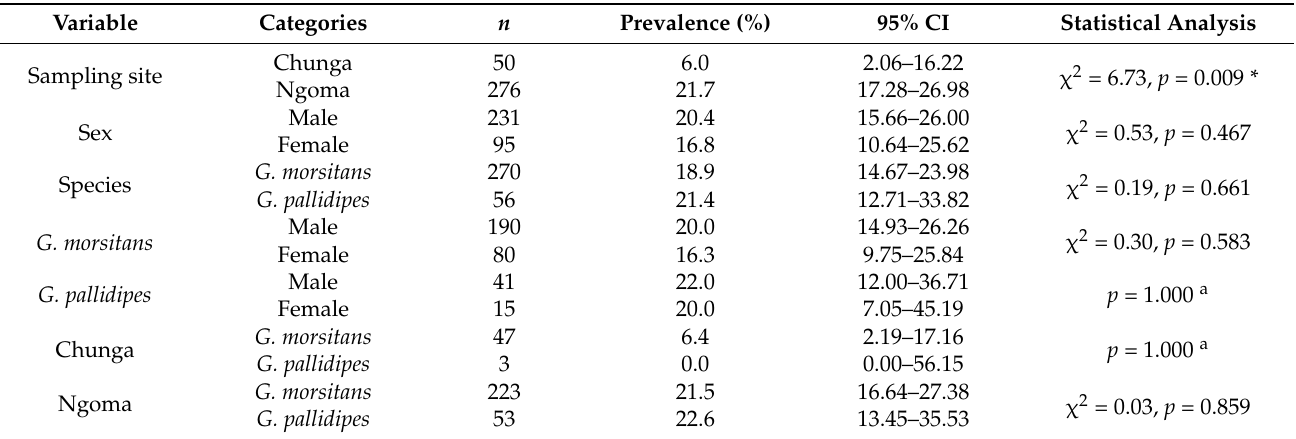
Figure 2. Tsetse fly population structure according to sex, species and sampling site. Note: Error bars correspond to 95% confidence interval. Table 2. Prevalence of African trypanosomes in relation to sex, species and sampling site of tsetse